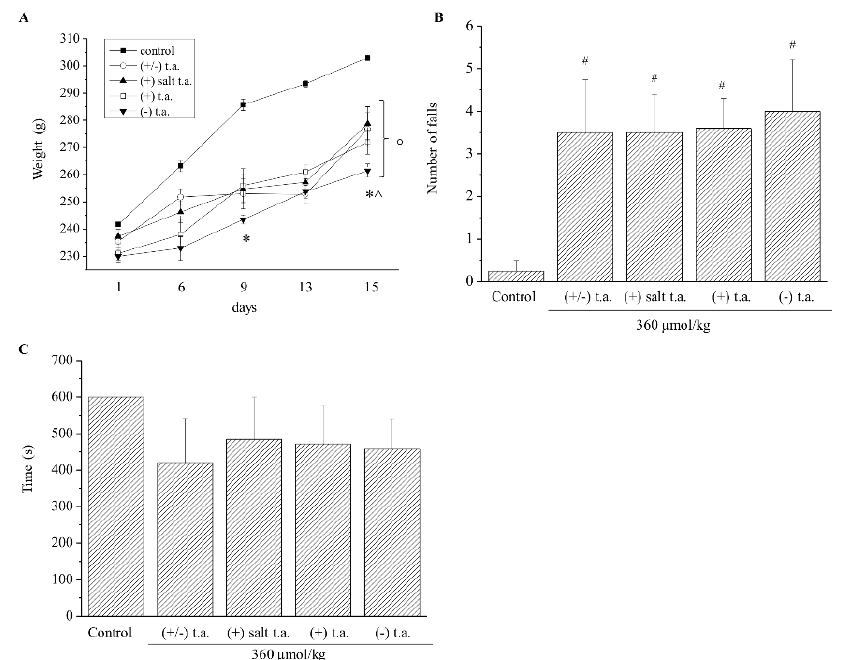
Figure 3. Subchronic toxicity treatments: body weight and ataxia. Effects of 15-day subchronic toxicity treatment with 360 µmol/kg of thioctic acid (t.a.) racemate, (+) enantiomer tromethamine salt, (+) enantiomer acid, (−) enantiomer on ( A ) body weight, ( B ) number of falls during 10 min of walking on the rotating rod and ( C ) time of continuous walking on the rotating rod. Each value represents the mean ± SEM of 6 rats per group. ° p < 0.05 vs animals treated with physiological solution from Day 6, * p < 0.05 vs animals treated with racemate, ^ p < 0.05 vs animals treated with (+) enantiomers, # p < 0.05 vs animals treated with physiological solution.